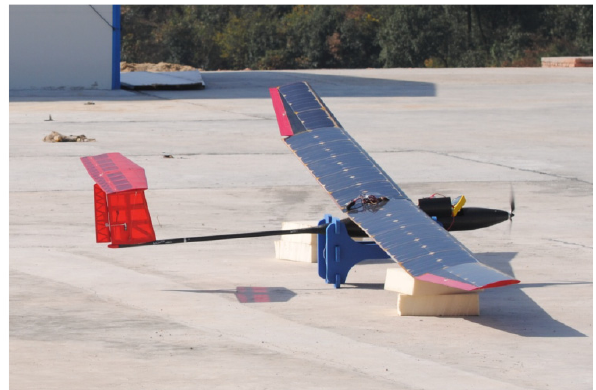
Figure 12. Prototype solar aircraft developed by NUDT.